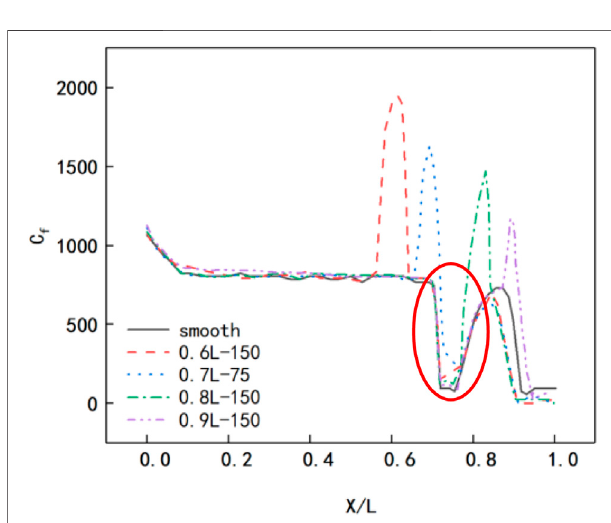
FIGURE 14 | Variation of the skin friction coef fi cient on the suction side with roughness height.